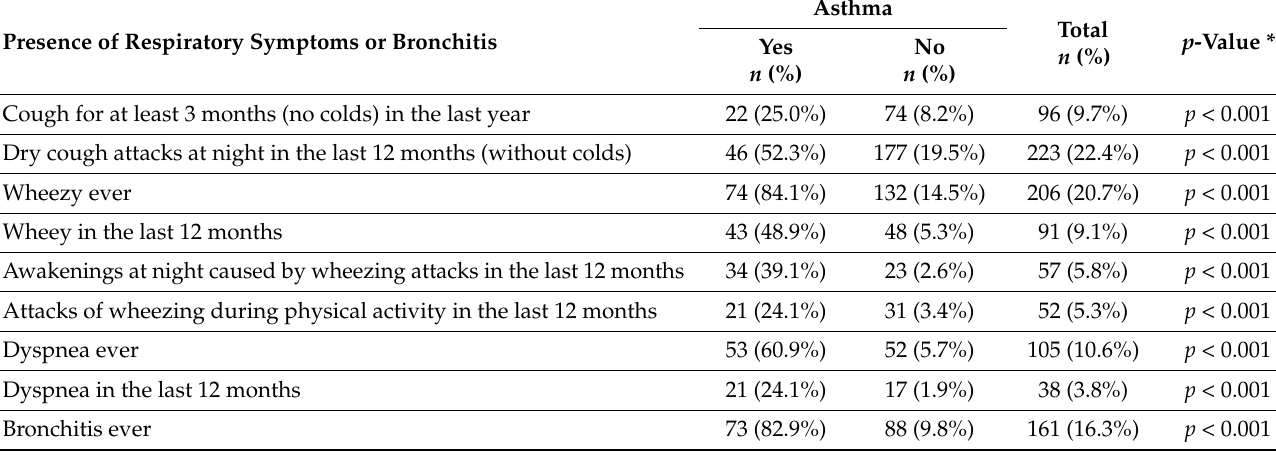
Table 3. Respiratory symptoms and diagnosis of asthma.